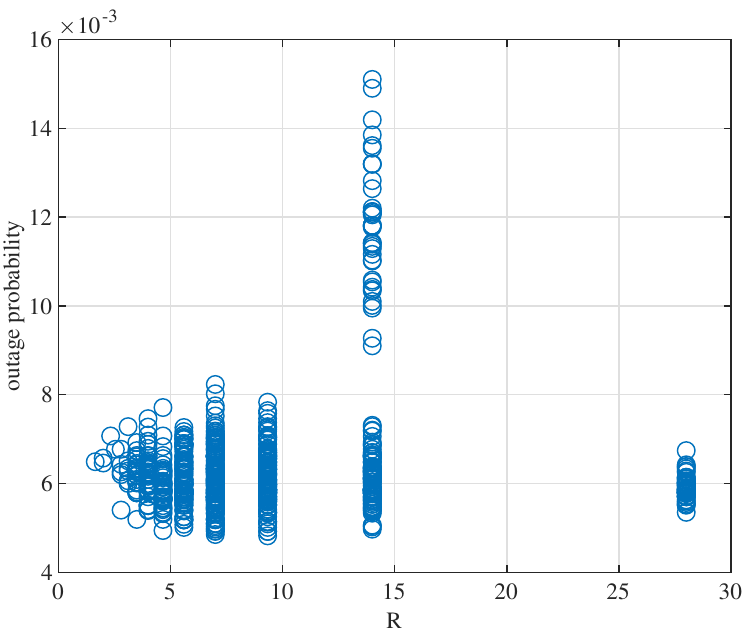
Figure 8. Scatter plot of 800 arrays showing the outage probability compared to the redundancy ratio R